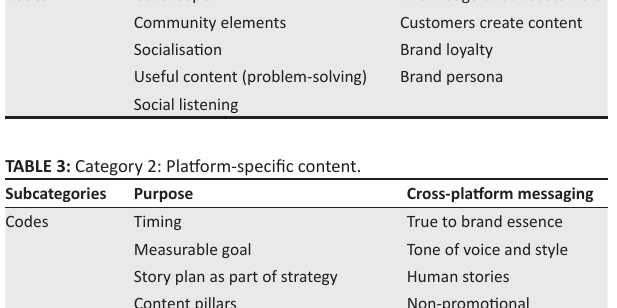
TABLE 2: Category 1: Building content communities. Subcategories